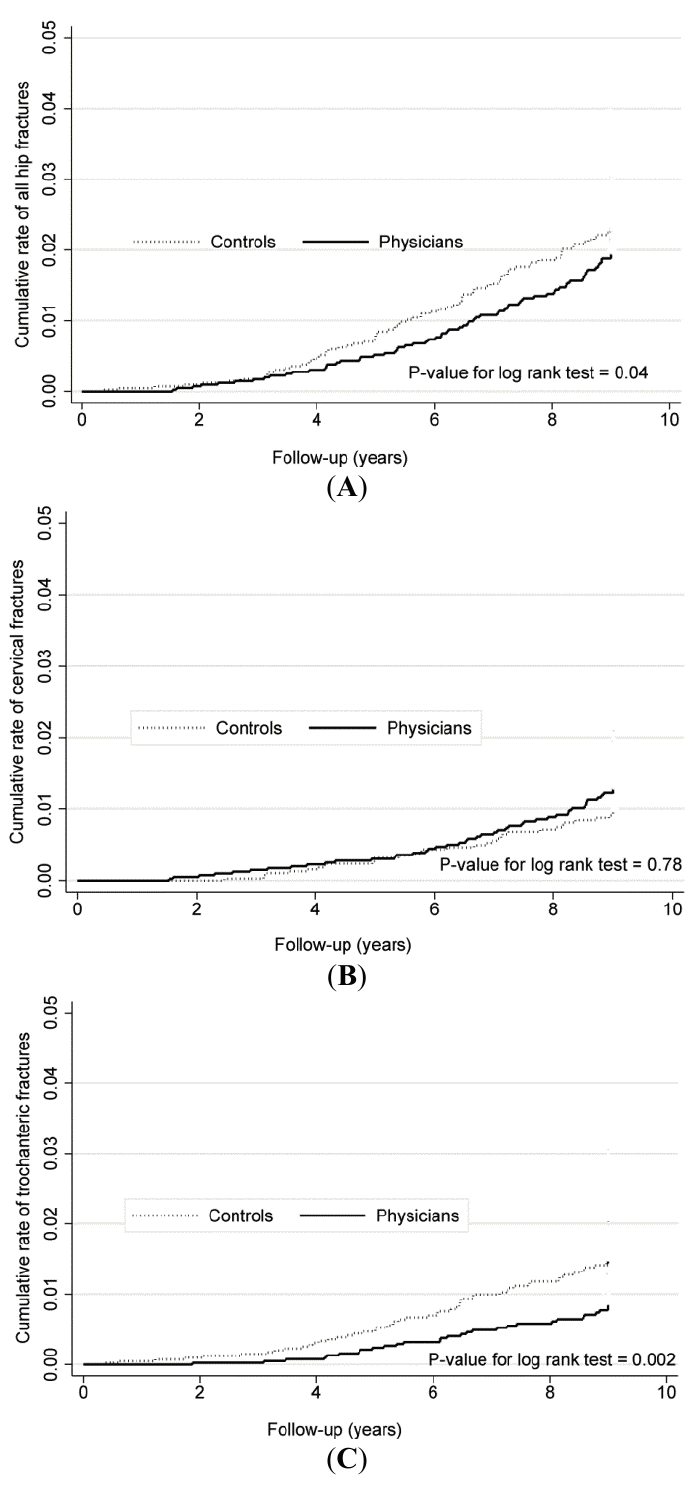
Figure 1. Comparisons of Kaplan-Meier failure estimates of overall ( A ) and type-specific hip fractures ( B , C ) between the two groups,